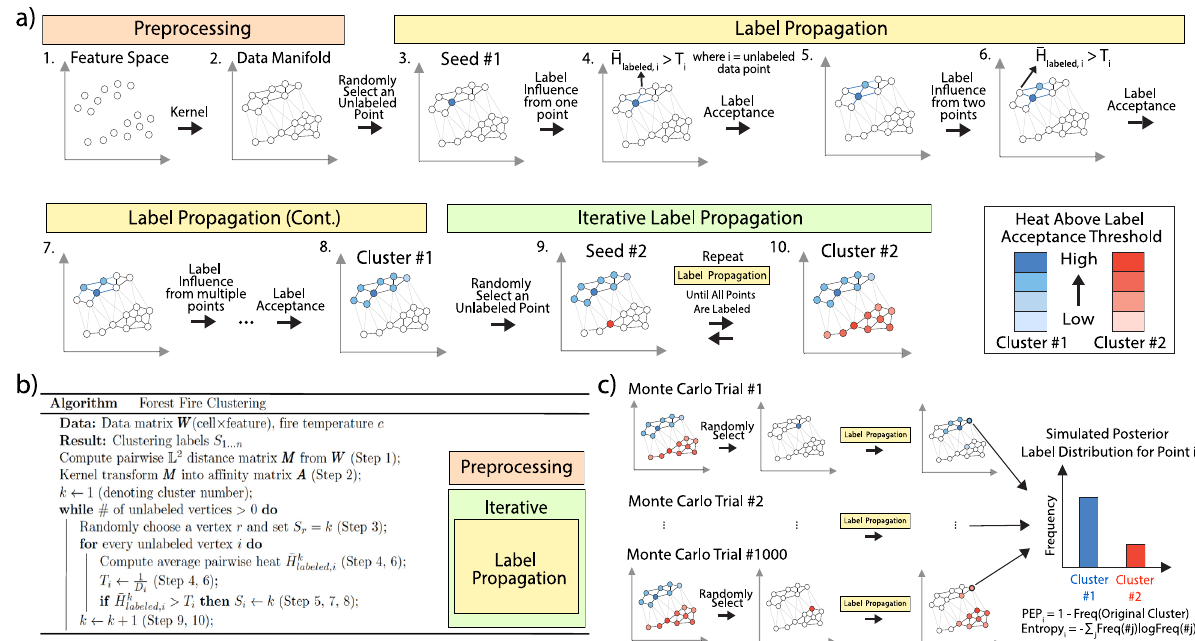
Fig. 1 Illustration of Forest Fire Clustering and Monte Carlo validation. a Illustration of Forest Fire Clustering. In the data-preprocessing stage, a KNN data graph is created by transforming the pairwise distances into af fi nities using adaptive kernels (Steps 1 – 2). Then, a vertex is randomly selected as the seed to take on a label (Step 3). The label is allowed to propagate to other vertices by determining if the average label in fl uence crosses the threshold at each vertex (Steps 3 – 8). Lastly, the process is iteratively repeated until all vertices have been given a label (Steps 9 – 10). b Pseudo-code for the Forest Fire Clustering algorithm. c Posterior label distributions are computed for each data point. Labels are repeatedly propagated from random seed vertices with the same set of parameters. For each point, the labels over all Monte Carlo trials are collected to construct an empirical posterior label distribution, which can be used to compute the posterior exclusion probability and the label